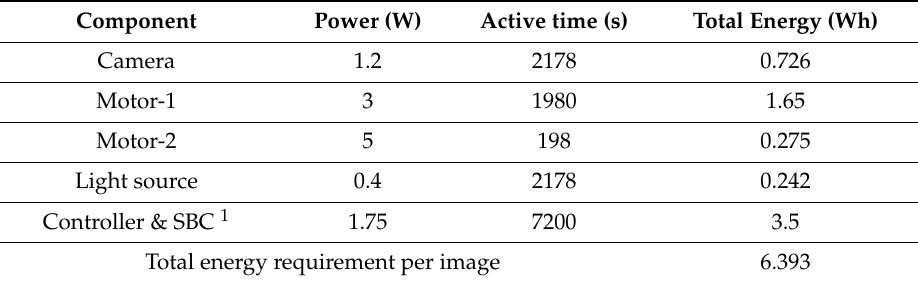
Table 2. Component energy requirement per